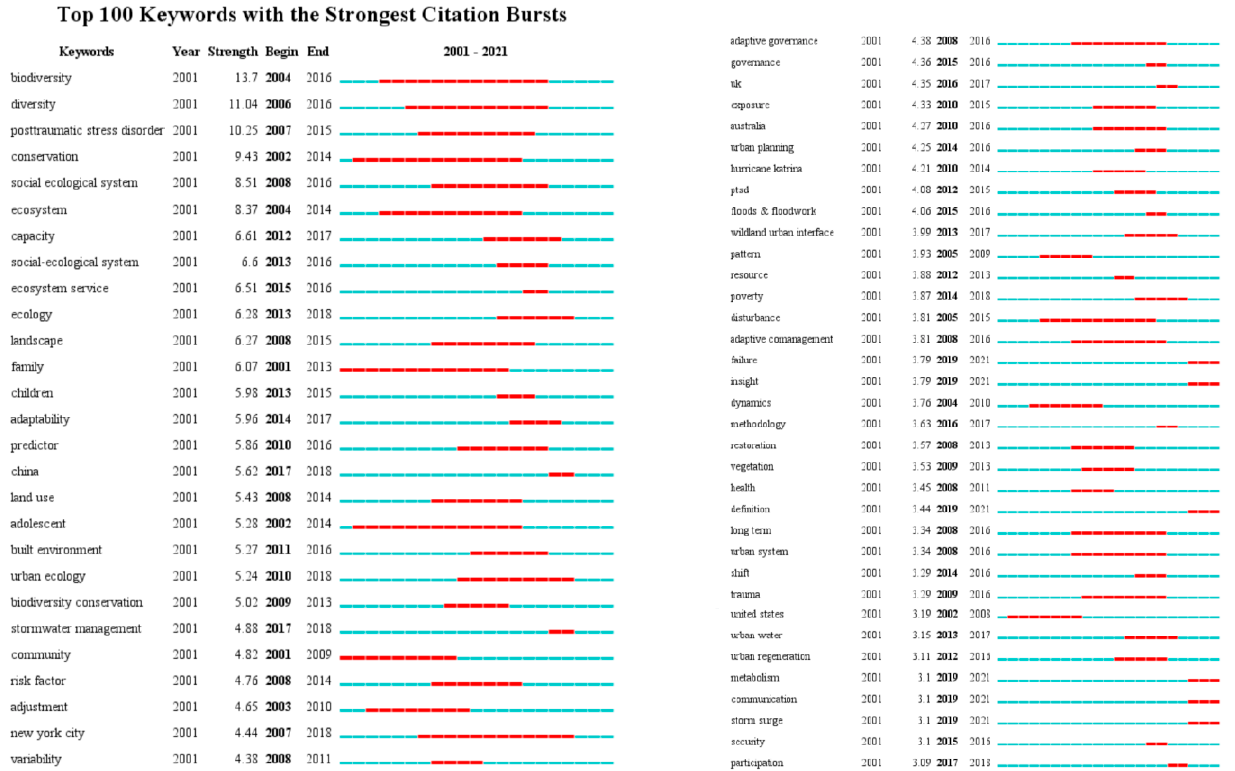
Figure 10. Top 100 keywords with the strongest citation bursts.